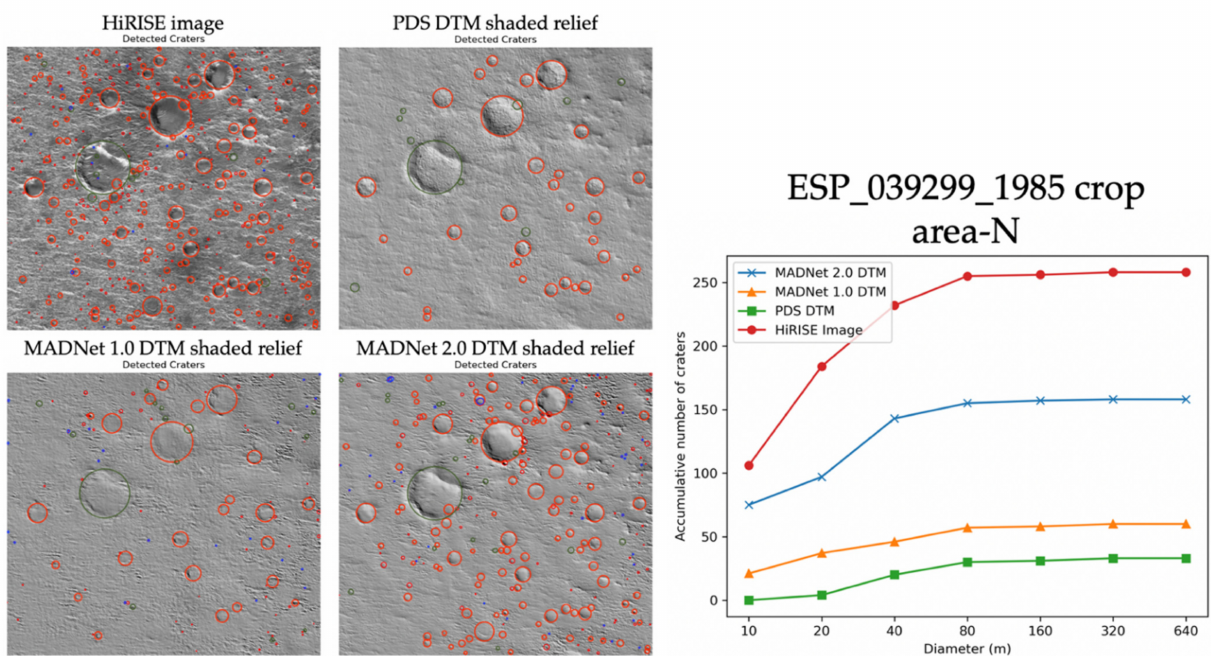
Figure 19. Crater detection and size-number counting from HiRISE image and the hill-shaded relief images of the PDS DTM, MADNet 1.0 DTM, and MADNet 2.0 DTM, over a 1.5 km × 1.5 km cropped area (area-N of ESP_039299_1985_RED). N.B. automatically detected craters are in red circles; manually excluded false-positives are in blue circles; manually added true-positives are in green circles.